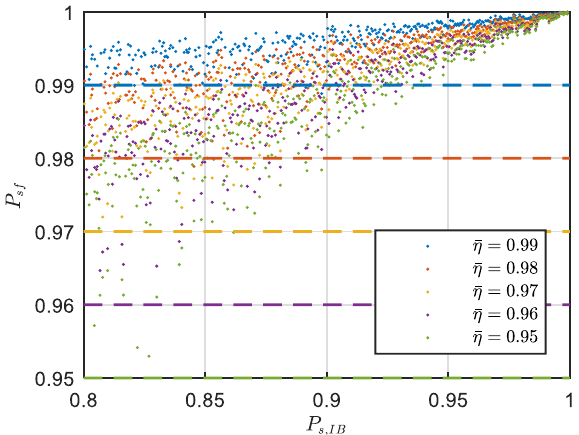
Figure 8. The success fixed rate of the FL-approach.